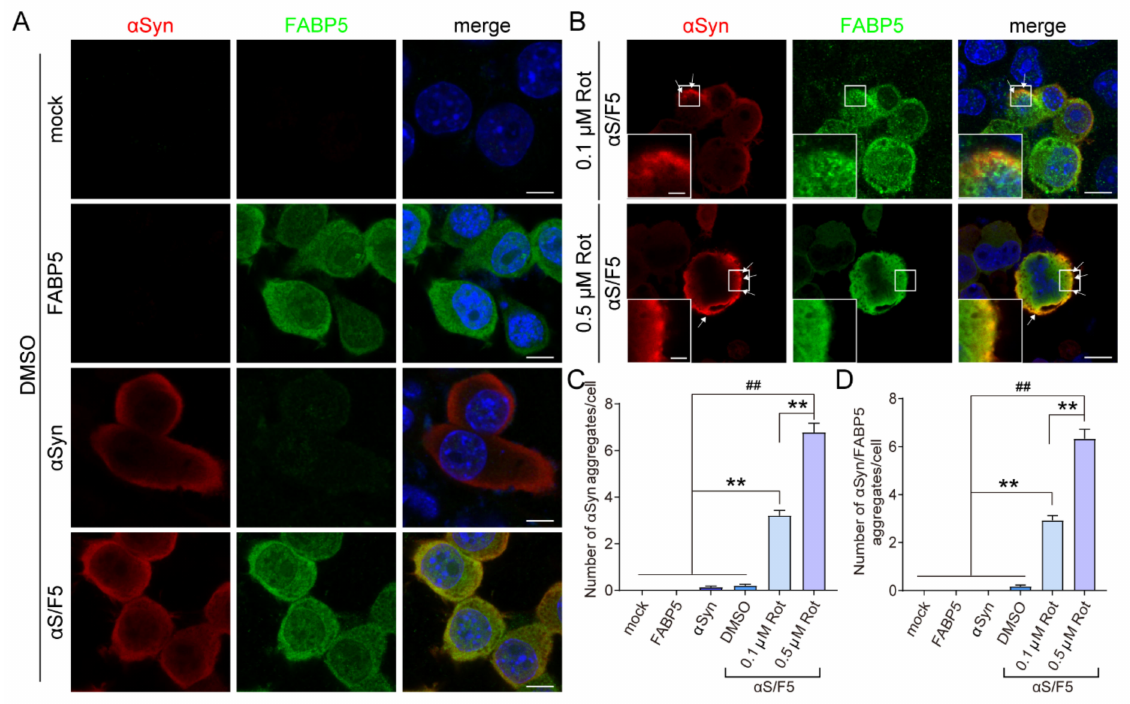
Figure 3. FABP5 co-localized with rotenone-induced α -Synuclein aggregates. ( A , B ) Representative images of immunoflu- orescent staining showing localization of α Syn (red), FABP5 (green), and DAPI (blue) in Neuro-2A cells. ( A ) Cells were transfected with pcDNA 3.1, FABP5 , α Syn , and α S/F5 respectively, then exposed to DMSO. Scale bars: 10 µ m. ( B ) α S/F5 - transfected cells were exposed to 0.1 or 0.5 µ M rotenone. Arrows indicate α Syn aggregates in cells treated with rotenone. Scale bars: 10 µ m. The region of interest is indicated with a white square and magnified in insets. Scale bars in the higher magnifying images: 2 µ m. ( C , D ) Quantitative analyses of the numbers of α Syn aggregates and α Syn/FABP5 positive aggregates. Results are presented as means ± SEM ( n > 40 cells from three respective cell experiments). ** p < 0.01, vs. 0.1 µ M rotenone-treated α S/F5 cells; ## p < 0.01, vs. 0.5 µ M rotenone-treated α S/F5